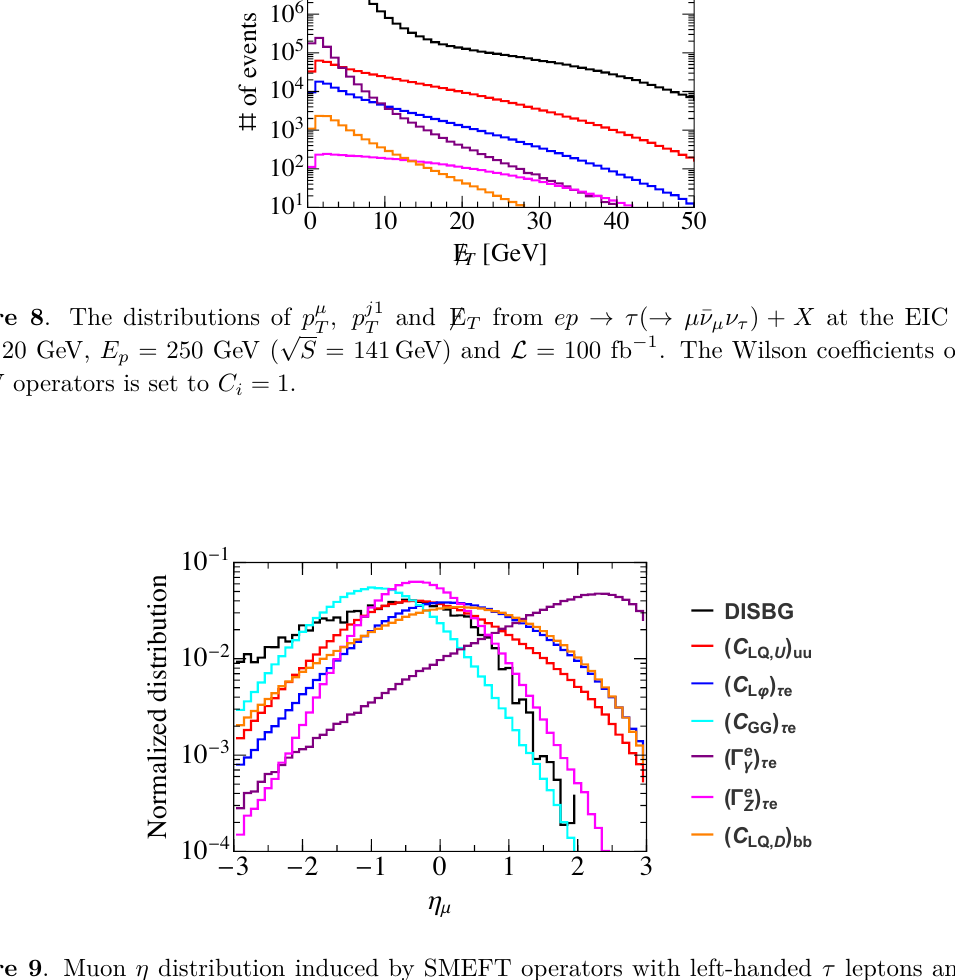
√ = 20 GeV and E = 250 GeV ( S = 141 e p